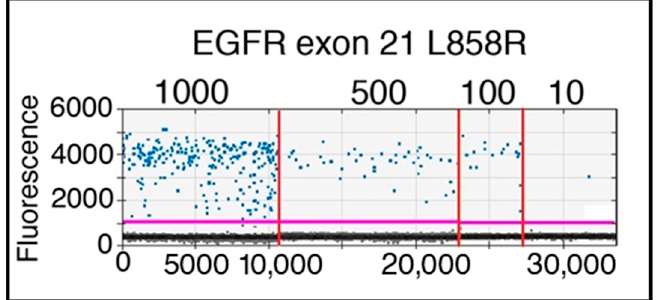
Figure 6. 1-D plot showing ddPCR results of spike-in samples performed with H1975 mutated cell line in healthy donor blood sample. The ordinate scale indicates fluorescence intensity. The magenta line is the fluorescence-threshold, above which droplets (blue) containing EGFR p.L858R mutated copies are present. Serial dilutions, from 1000 to 10 H1975 cells, are separated by the vertical red lines.